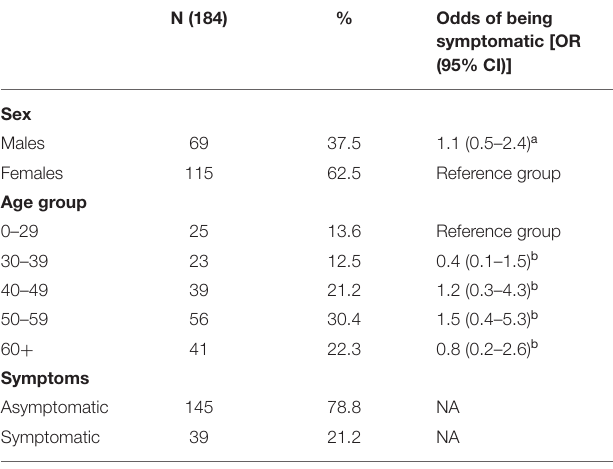
TABLE 1 | Subject characteristics and odds of being symptomatic.